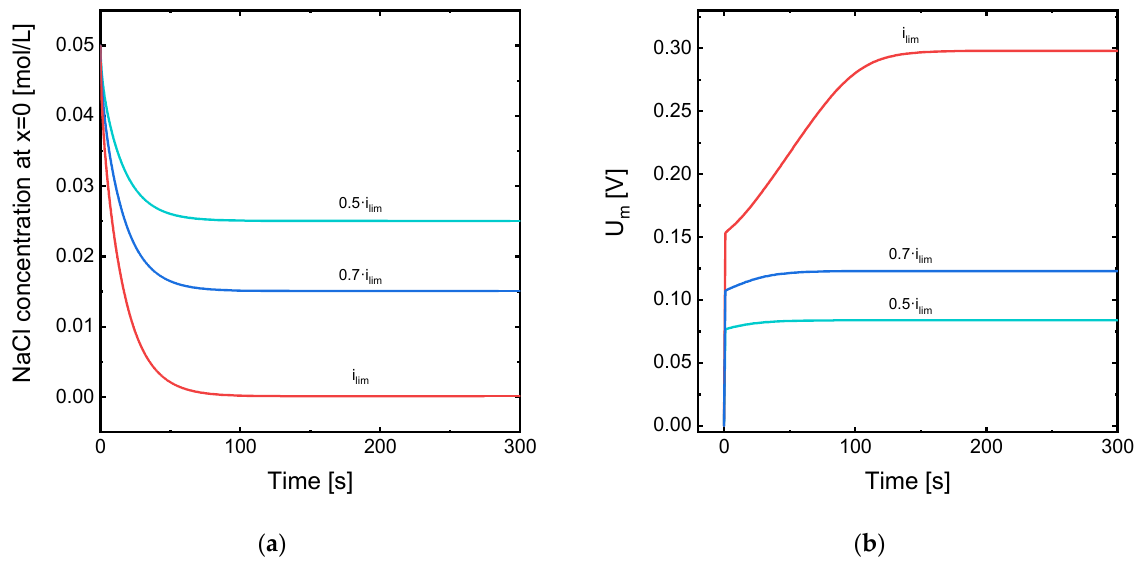
Figure 4. ( a ) Evolution with time of the NaCl concentration at the interface between the membrane surface and the diluting DBL (position x = 0) for different levels of applied current density; ( b ) evolution with time of the membrane system potential drop ( U m ) for different levels of applied current density.